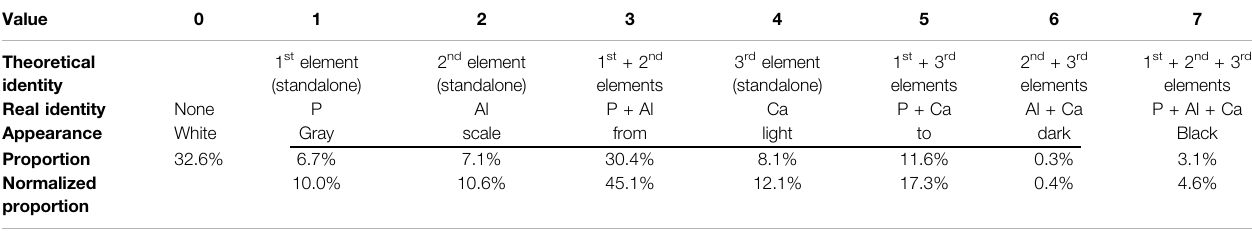
TABLE 1 | Possible values for theoretical identity (1 – 7) in a combined image for three elements and results of the elemental images combination. Value